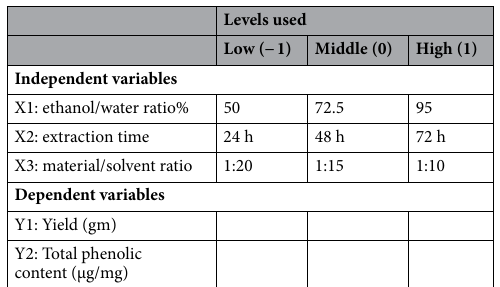
Table 1. Actual and coded levels of the variables studied in